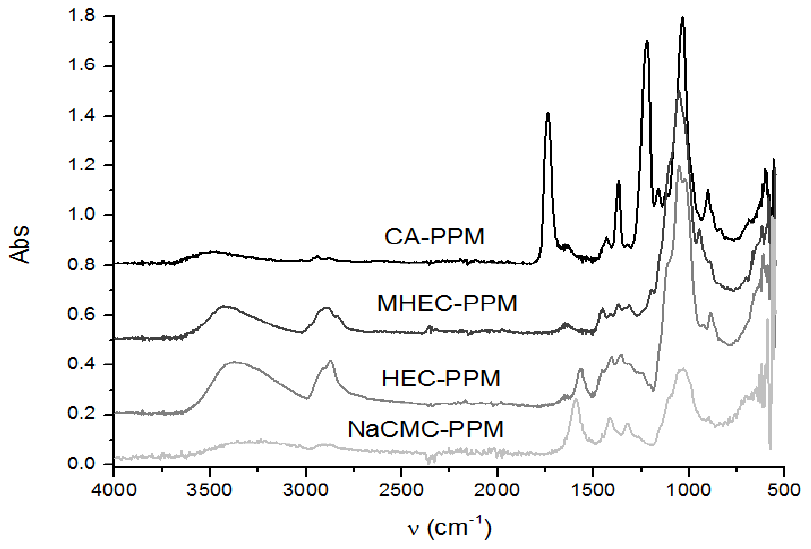
Figure 7. The Fourier transform infrared spectroscopy (FT–IR) spectrum of the impregnated membranes. Table 6. The main structural characteristics identified through Fourier transform infrared spectroscopy (FT–IR).